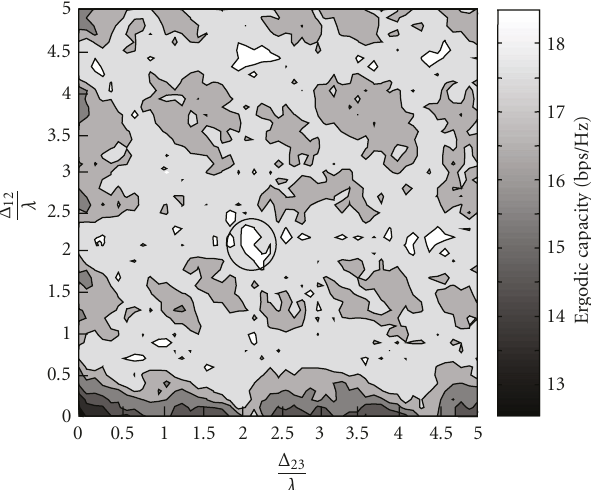
Figure 9: Setting B: ergodic capacity C ( Δ , η ) averaged with respect to the distribution of shadowing ( r = 50m). Circle denotes the op- timal